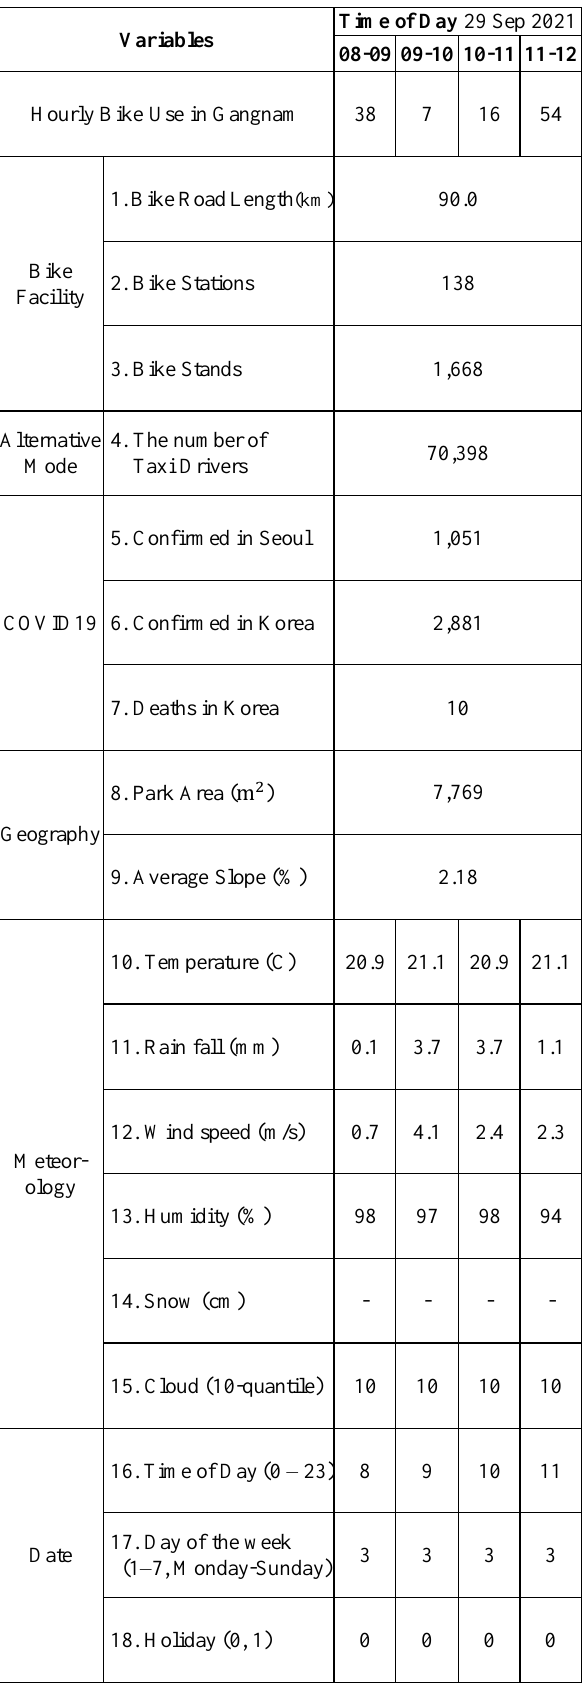
Table 1 . Example of Bike Use and Social Environmental Data in District Gangnam on 29 Sep t.